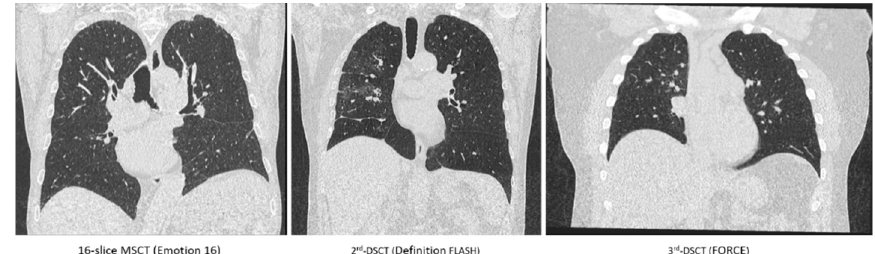
Figure 1. Representative coronal CT sections of the lung reconstructed from data acquired in inspiration for three different patients at the CT systems considered using the scan protocols summarized in Table 1 (identical windowing of Hounsfield values).